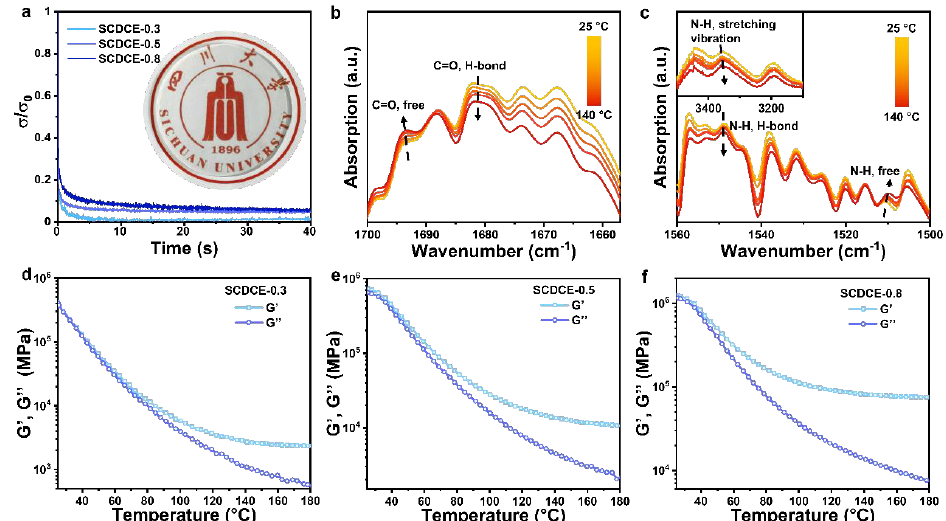
Figure 3. Dynamic properties. ( a ) Stress relaxation curves of SCDCEs samples. The samples are stretched to a strain of 0.1% for 40 s. Temperature-dependent FTIR spectra at ( b ) 1700–1660 cm − 1 , ( c ) 1580–1500 cm − 1 and 3500–3100 cm − 1 of SCDCE-0.3 upon heating from 25 ◦ C to 140 ◦ C. ( d – f ) Depen- dence of the SCDCEs samples G (cid:48) and G (cid:48)(cid:48) moduli on temperature. The samples are stretched to a strain of 0.1% at a constant frequency of 1.0